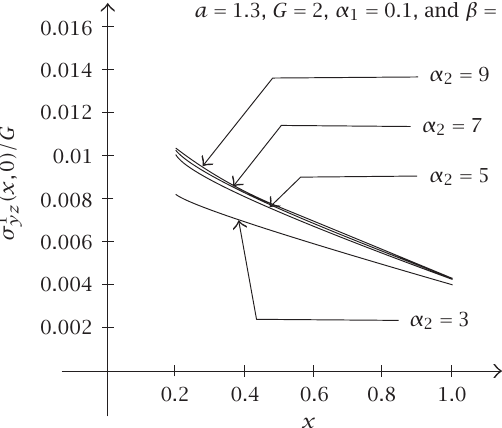
x for different values of 1 with = 0 . 1, and β = 2. 1